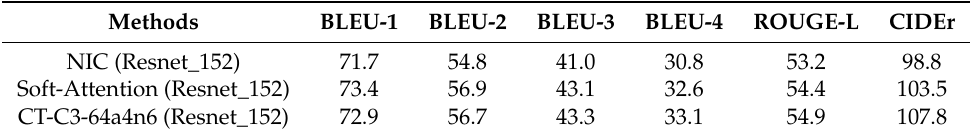
Table 4. The results of the CT model with the Resnet_152 as the encoder.